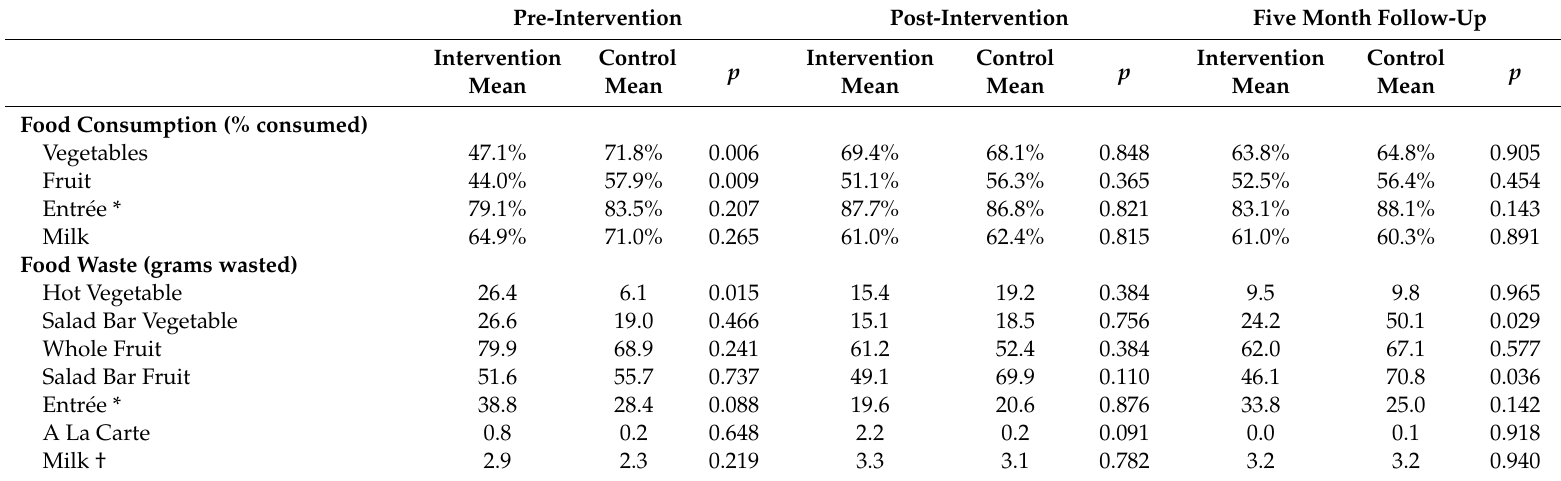
Table 6. Di ff erences in Food Consumption and Waste between Intervention and Control Groups at Pre-Intervention, Post-Intervention, and Five Month Follow-Up.